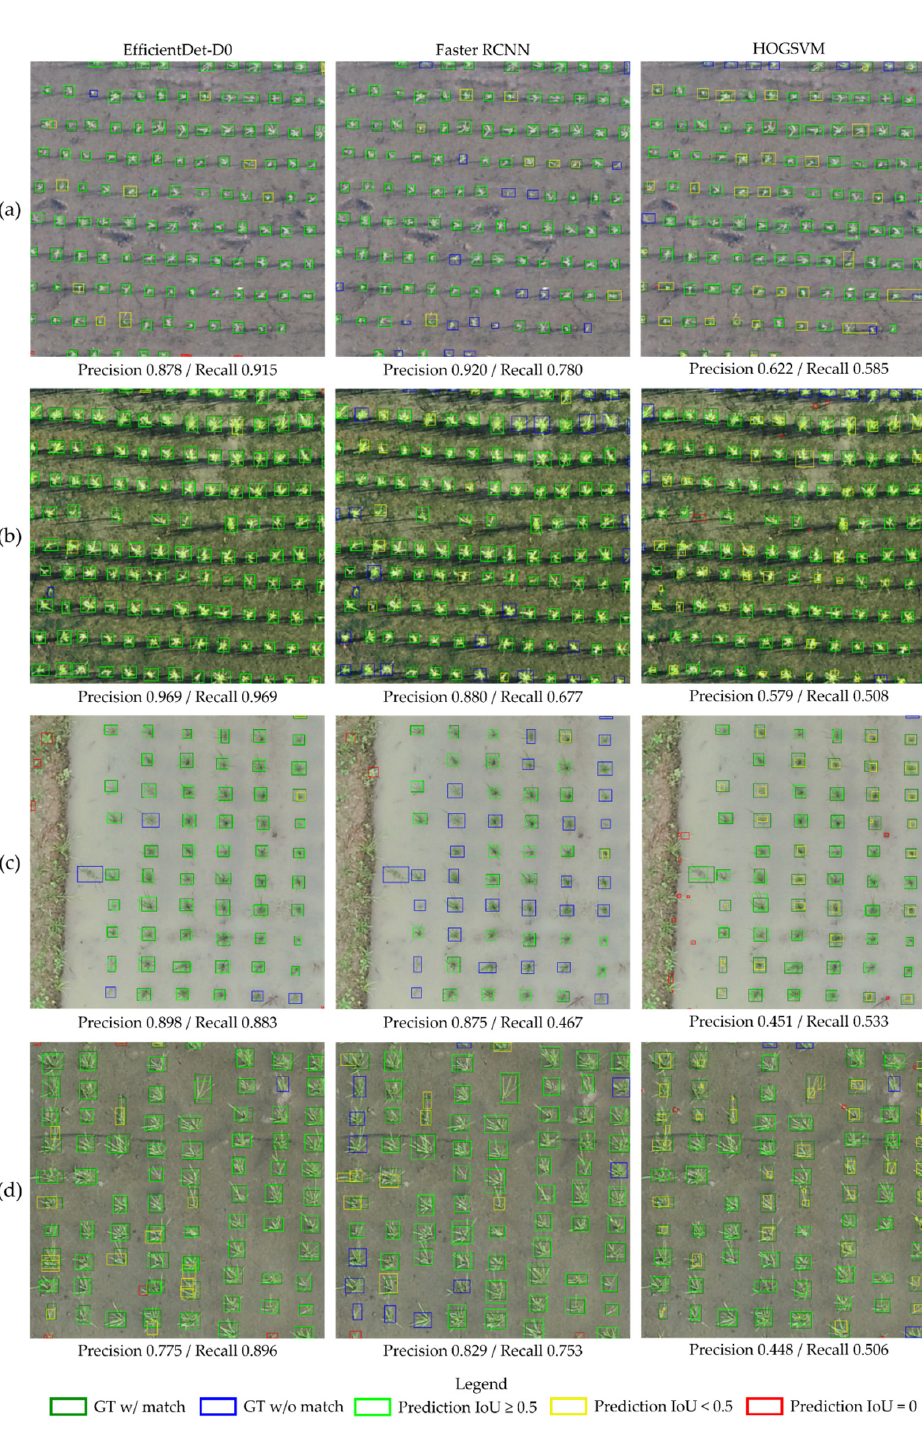
Figure 18. An example of detection results with precision and recall metrics on four datasets: ( a ) 7 August 2018, ( b ) 14 August 2018, ( c ) 12 August 2019 and ( d ) 20 August 2019.